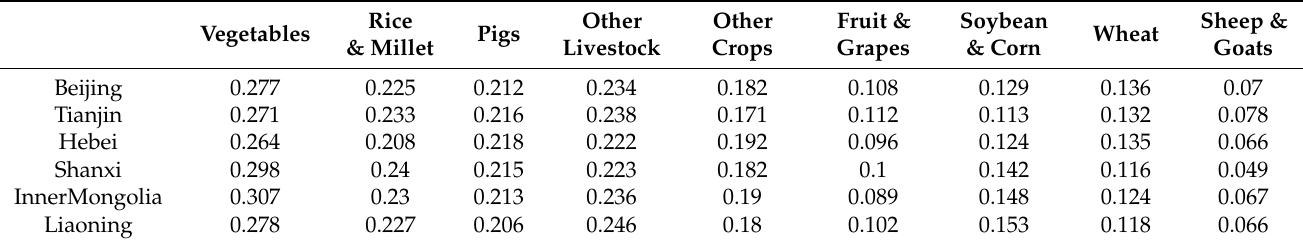
Table 2. Changes in agricultural production output in 31 provinces under SIS scenario (%).